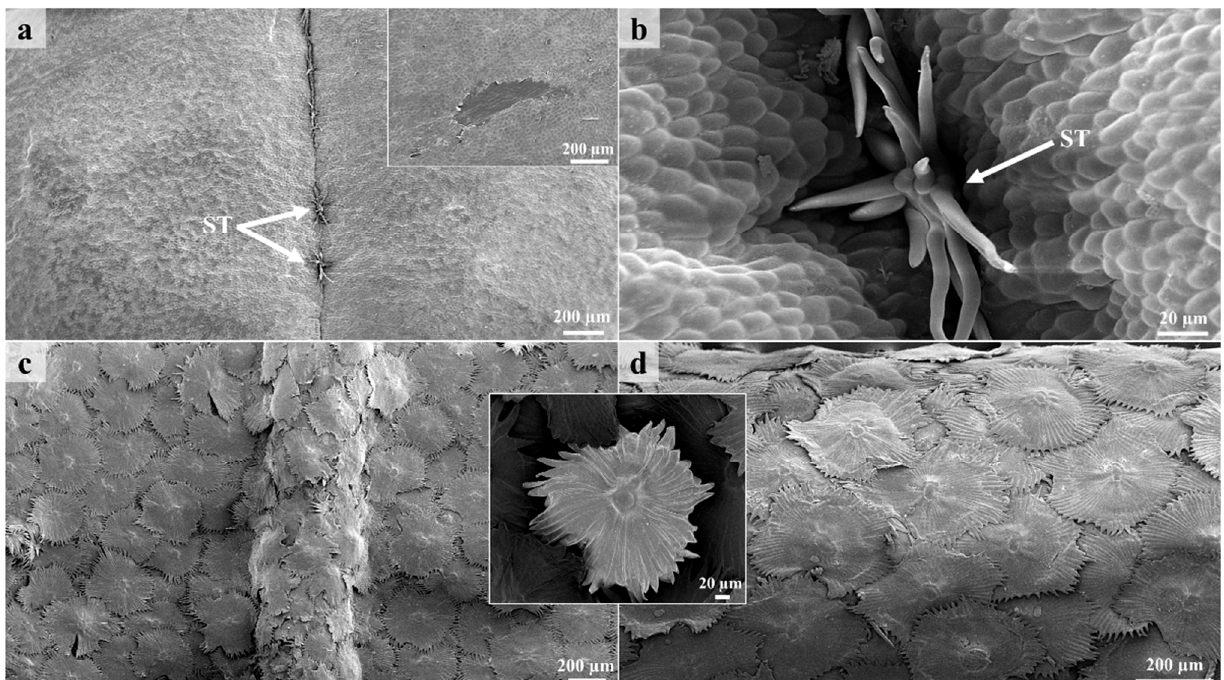
Figure 1. Stereomicrographs of stem and leaf surfaces. ( a ) Glabrous lamina showing translucent dots on adaxial surface. ( b ) Stellate trichome along sunken mid-vein on the adaxial surface. ( c ) Lamina of abaxial surface densely covered with lepidote trichomes. ( d ) Mid-vein on abaxial surface covered with lepidote trichomes. ( e ) Extrafloral nectaries present on the mid-vein at the base of the leaf. ( f ) Dense indumentum of lepidote trichomes on stem.